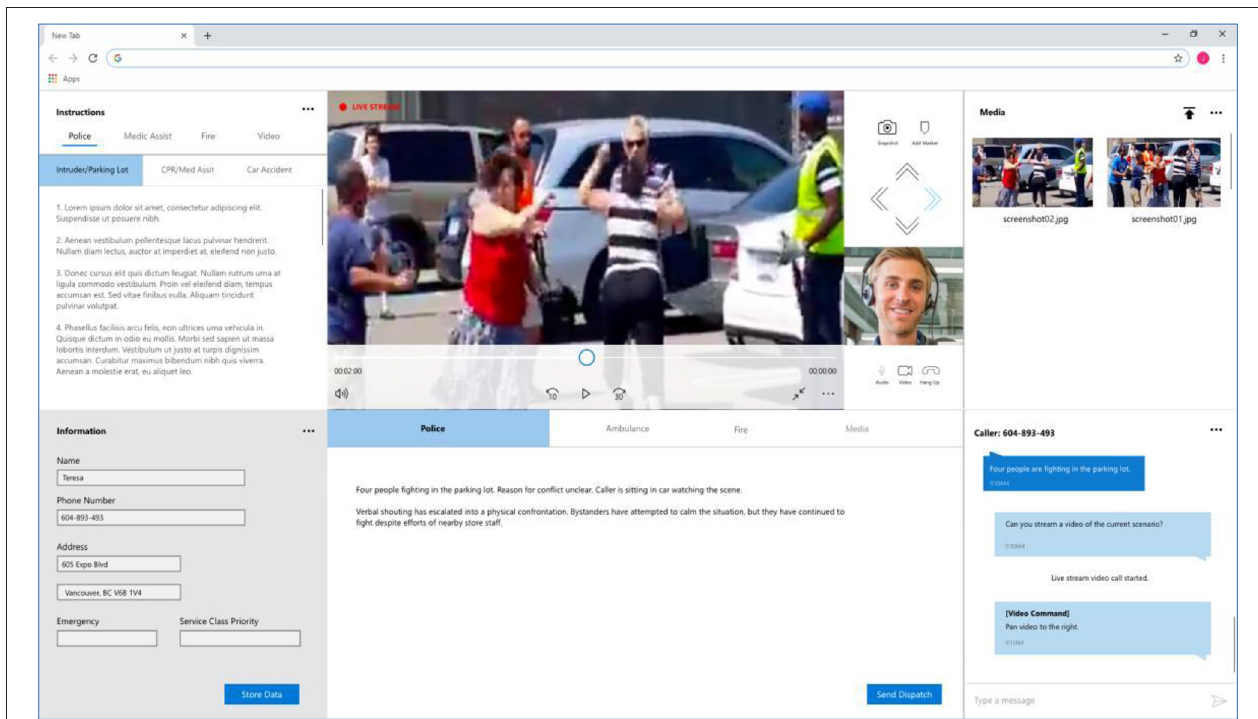
FIGURE 9 | Updated UI, digital media main